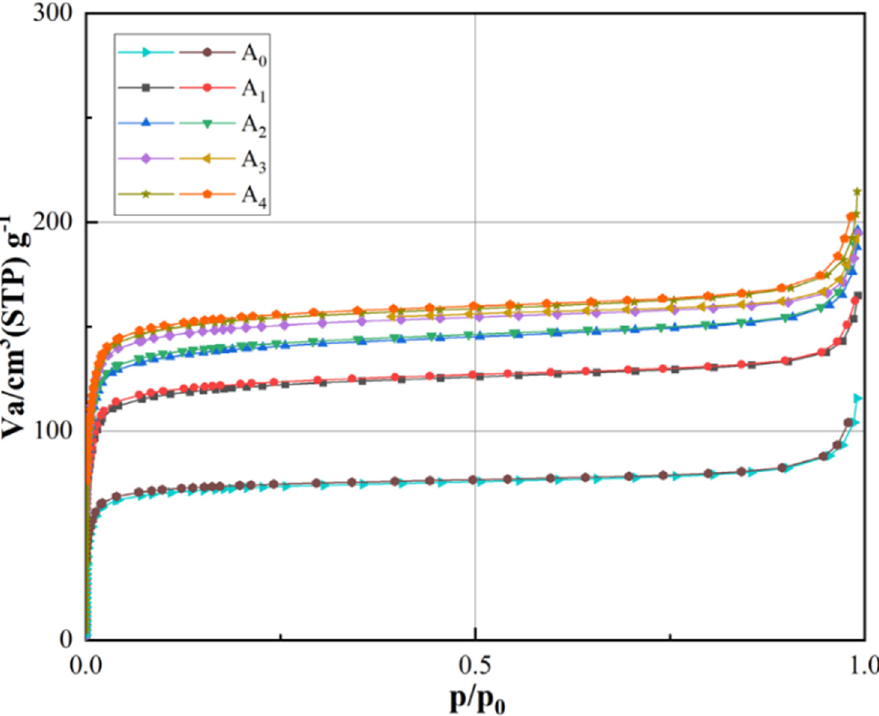
Figure 6. Nitrogen adsorption/desorption isotherms generated for the UiO − 66 − NH 2 system synthe- sized under conditions of varying silver doping levels. Table 1. Porous structure parameters of different samples.